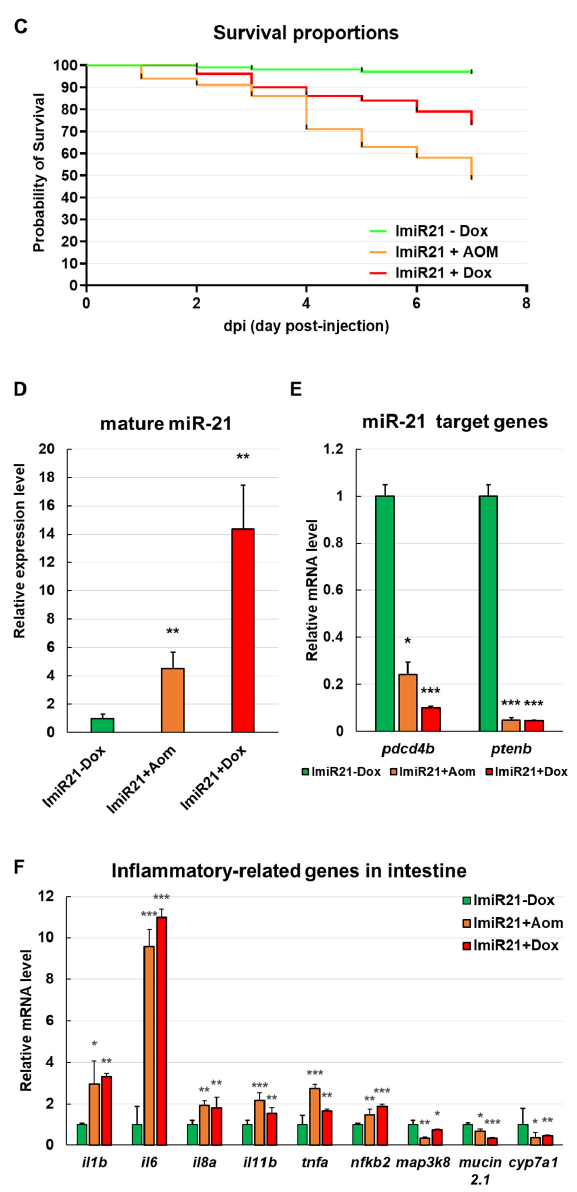
Figure 3. Characterization of expression profiles of inflammation-related genes in ImiR-21 larvae. ( A ) Schematic diagram of the strategy of doxycycline (Dox) and azoxymethane (AOM) treatment in ImiR-21. ImiR-21 + AOM: ImiR-21 larvae were injected with AOM (100 ng/4.6 nL) at 14, 16, and 18 days post-fertilization (dpf). ImiR-21 + Dox: ImiR-21 larvae were treated with 25 µ g/mL Dox from 3 to 21 dpf. Morphology and gene regulatory patterns were analyzed at 21 dpf. ( B ) Intestinal morphology of ImiR-21 at 21 dpf. ImiR-21 expressed a strong ZsGreen signal in the zebrafish intestine. Upon Dox treatment, the mCherry (and miR-21) signal was induced in the intestine. The intestine was swollen in ImiR-21 + AOM and ImiR-21 + Dox. Scale bar: 200 µ m. ( C ) Survival proportions of ImiR-21 from 14 to 21 dpf ( p < 0.0001 n = 100 in 3 independent experiments). ( D ) RT-qPCR analysis of mature miR-21 level in intestine of ImiR-21 ± Dox and ImiR-21 + AOM at 21 dpf. U6 was used as a reference gene for expression normalization. ( E ) The mRNA expression level of pdcd4b and ptenb in the intestines of ImiR-21 ± Dox and ImiR-21 + AOM at 21 dpf. ( F ) The mRNA expression level of inflammation-related genes in the intestine of ImiR-21 ± Dox and ImiR-21 + AOM at 21 dpf. Gene expression levels were normalized to gapdh levels in ImiR-21—Dox for panels ( E , F ). Statistically significant differences from PBS-injected WT control or ImiR-21—Dox are denoted by * ( p < 0.05), ** ( p < 0.01), and *** ( p < 0.001) for panels ( D – F